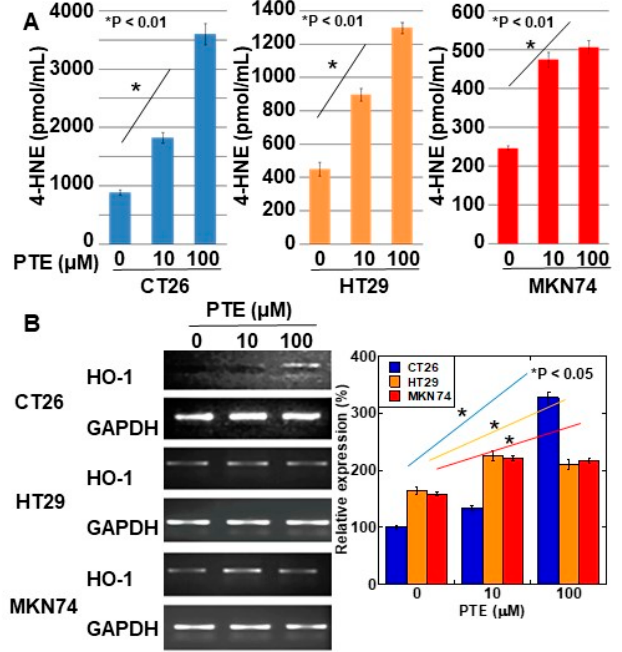
Figure 3. E ff ect of PTE on oxidative stress in cancer cell lines. ( A ) 4-hydroxynonenal (4-HNE) levels were measured by enzyme-linked immunosorbent assay (ELISA). Cells were treated with PTE for 48 h. ( B ) mRNA expression of heme oxygenase-1 (HO-1) was examined by RT-PCR. GAPDH was amplified as a loading standard. Right panel was semi-quantification of HO-1 expression examined by RT-PCR. Error bar, standard deviation from three independent examinations. Statistical di ff erence was calculated by ordinary analysis of variance. PTE, pterostilbene; HNE. Hydroxynonenal; HO, heme oxygenase.